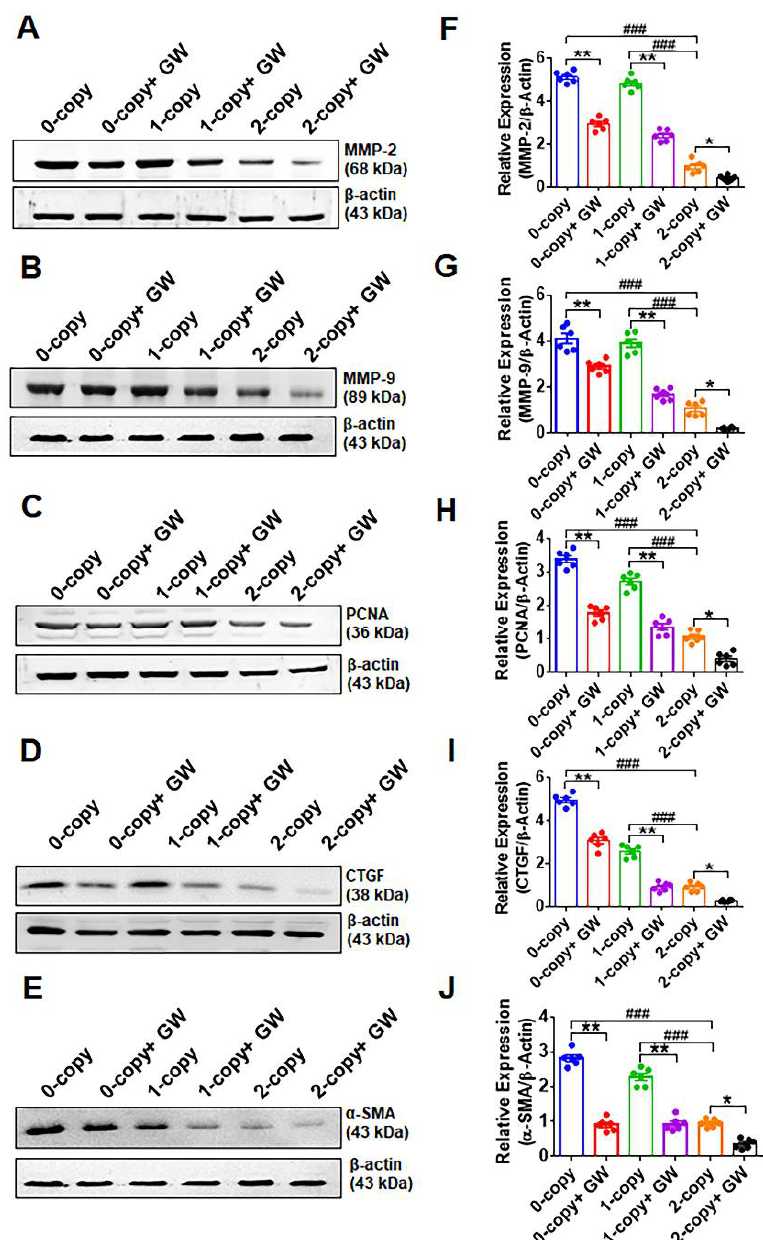
Figure 3. Western blotting analysis of extracellular matrix and fibrotic proteins in the heart tissues of control and drug-treated male Npr1 gene-disrupted mice: representative Western blots showing the levels of MMP-2, MMP-9, PCNA, CTGF, and α -SMA proteins (panels ( A – E )). The densitometry analysis of proteins was normalized to β -actin protein levels (panels ( F – J ). Values are expressed as means ± S.E. (n = 6 animals in each group). Statistical significance is expressed as ### p < 0.001, vehicle-treated 0-copy and 1-copy vs. 2-copy; * p < 0.05, ** p < 0.01, vehicle-treated 0-copy,1-copy and 2 copy vs. drug-treated same gene copy number.